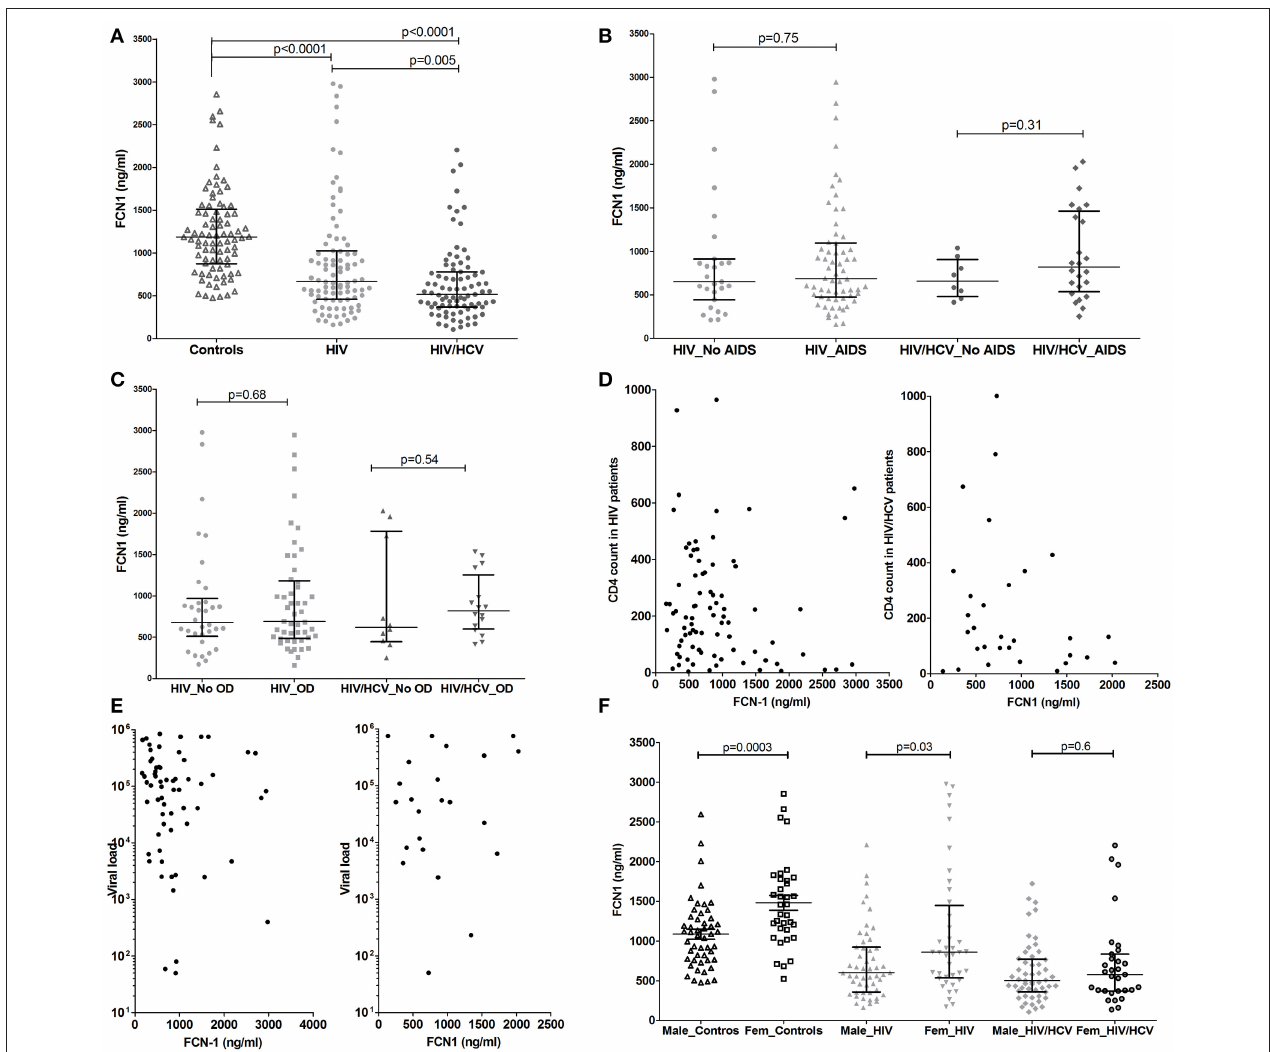
FIGURE 1 | Ficolin-1 plasma levels in controls and HIV infected and HIV/HCV coinfected patients (A) , considering the presence of AIDS (B) or opportunistic diseases (C) . Correlation between Ficolin-1 and T CD4 cell counts (D) , Ficolin-1 and HIV viral load (E) (Values are in Log10 scale) in patients of HIV and HIV/HCV. Ficolin-1 levels in male and female controls and patients (F)